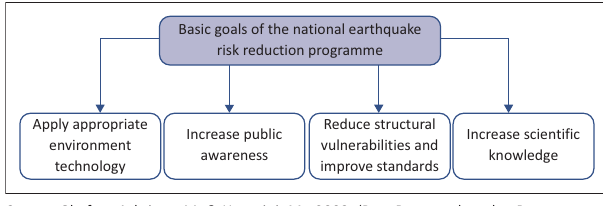
FIGURE 1: Basic goals of the national earthquake risk reduction